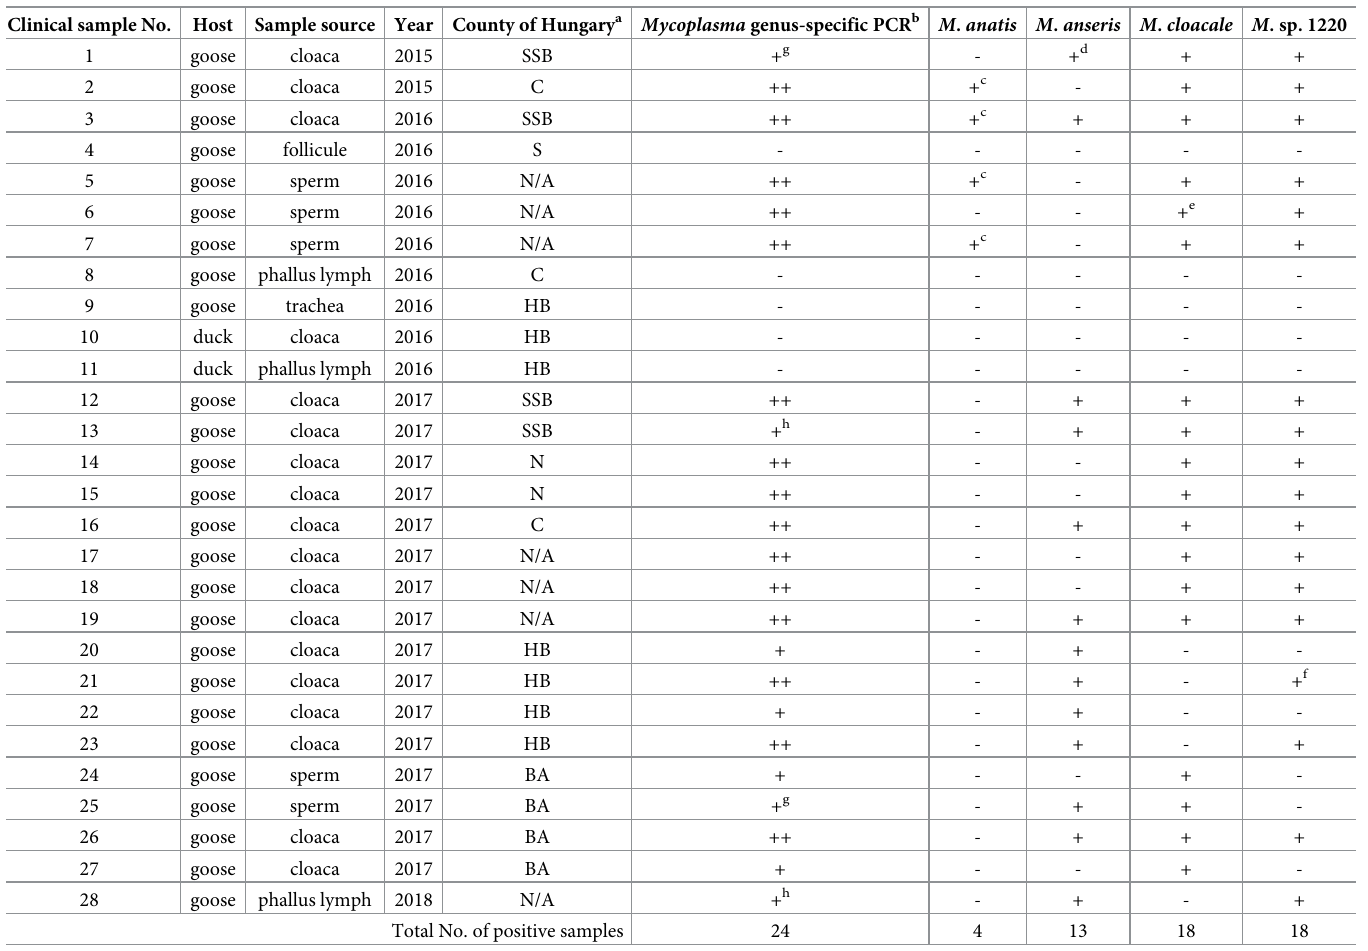
Table 2. Mycoplasma spp. detection in the clinical